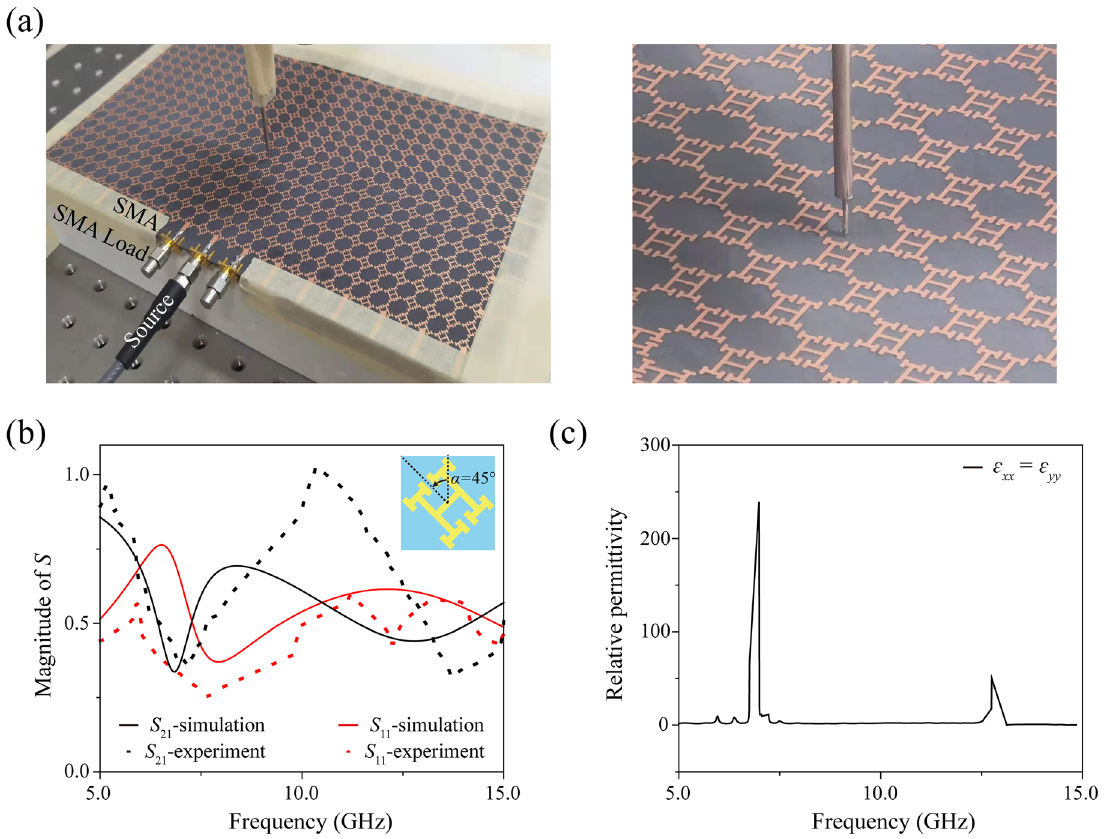
Figure 7: Experimental results. (a) Details of the measurement process in the microwave regime. (b) Transmission and reflection spectra of the measurements (points) and simulations (lines) when the source was polarized along the y axis. (c) Relative permittivity obtained from the